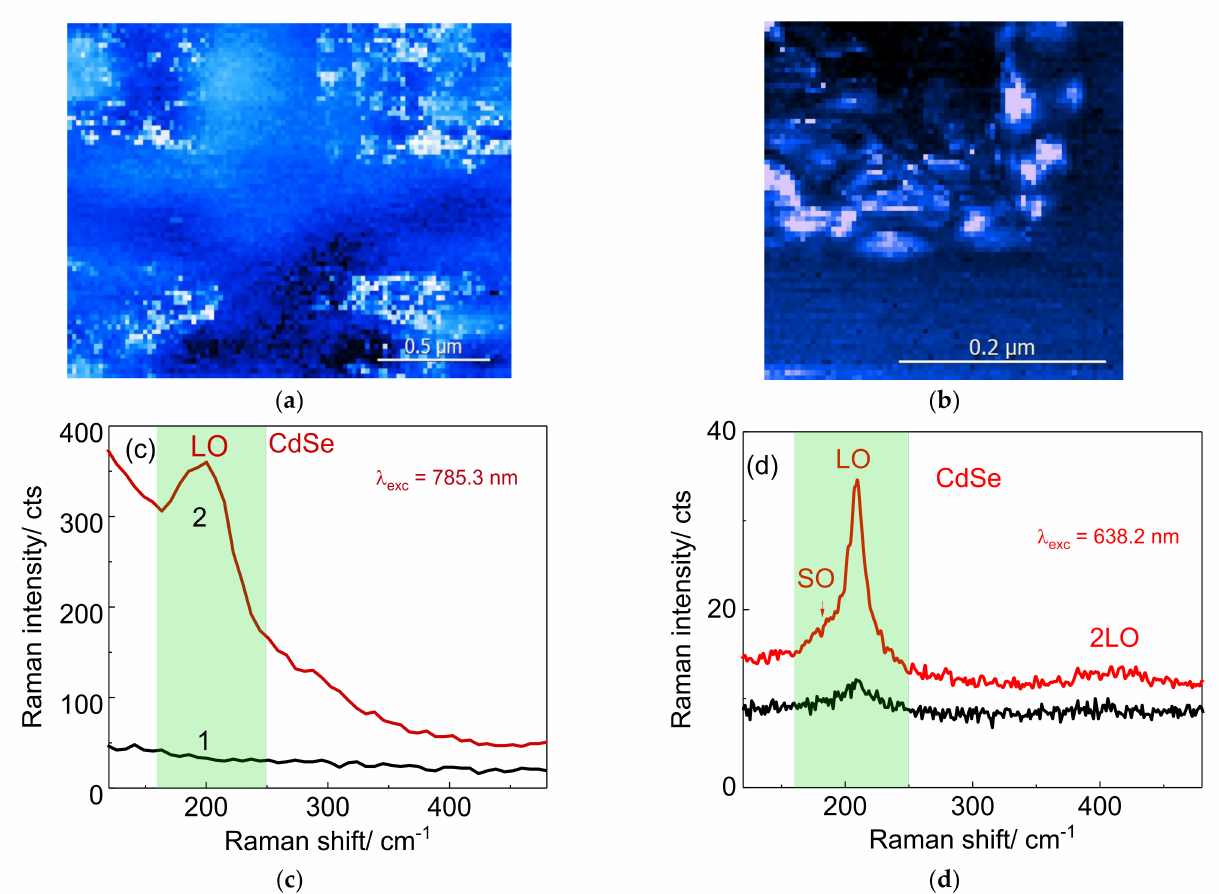
Figure 8. TERS mapping of Klarite structure at a wavelength of ( a ) 785.3 nm and ( b ) 638.2 nm. TERS maps indicate the intensity of the LO CdSe mode depending on the position of the tip during the TERS scan. The most intense TERS spectra, red spectra in ( c , d ) are taken from the TERS mapping in ( a , b ), measured by using 785.3 and 638.2 nm wavelengths, respectively. The black spectra in ( c , d ) were taken on a flat part of the gold